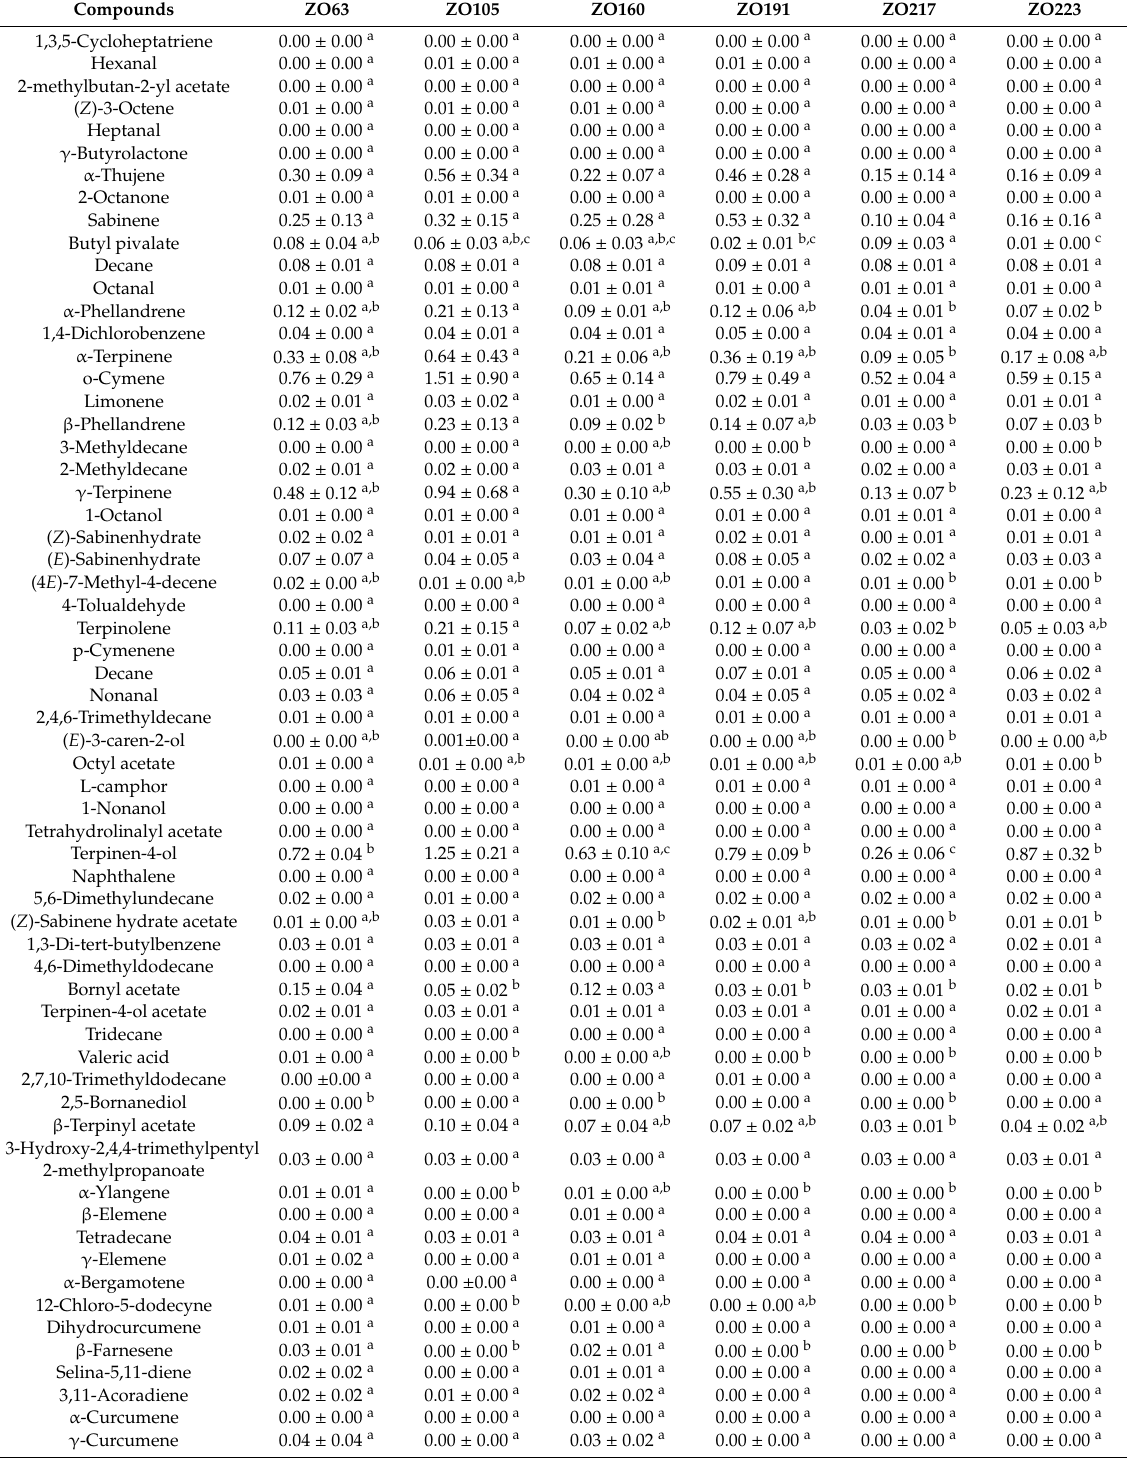
Table 1. Significant differences between identified volatile organic compounds (VOCs) in six Z. barbatum species.